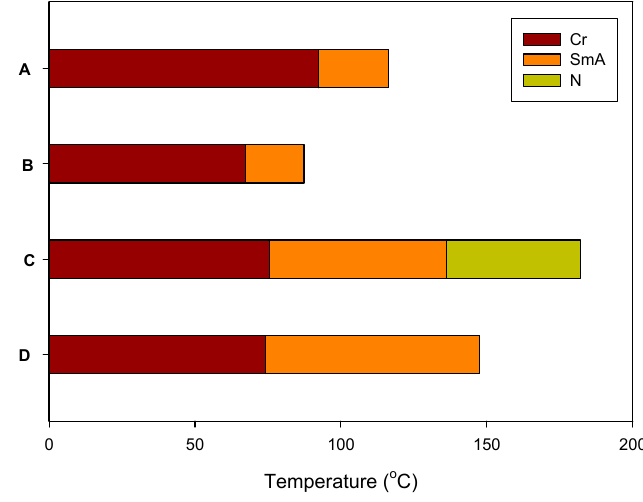
Figure 3. DSC transitions of series A – D upon heating.